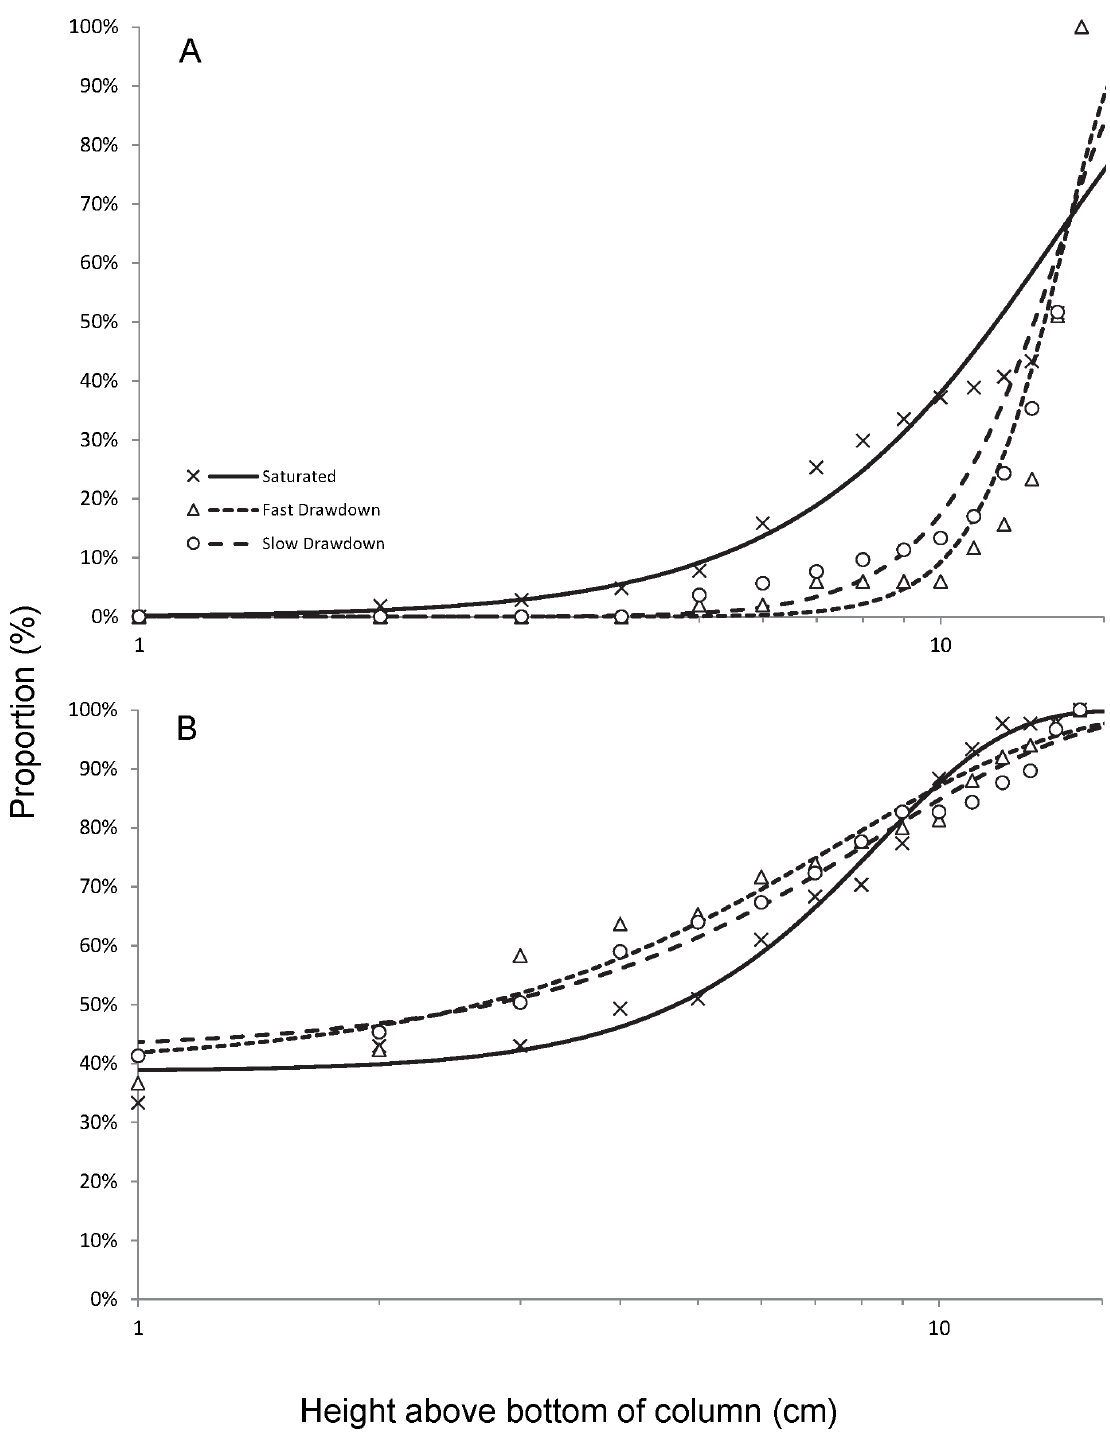
Figure 3. Cumulative depth distributions of copepods in saturated, fast and slow drawdown experiments. Comparison of depth distributions from A - the Wellington alluvium copepods and B - the Budderoo swamp copepods in sediment columns; zero depth refers to the base of the column.